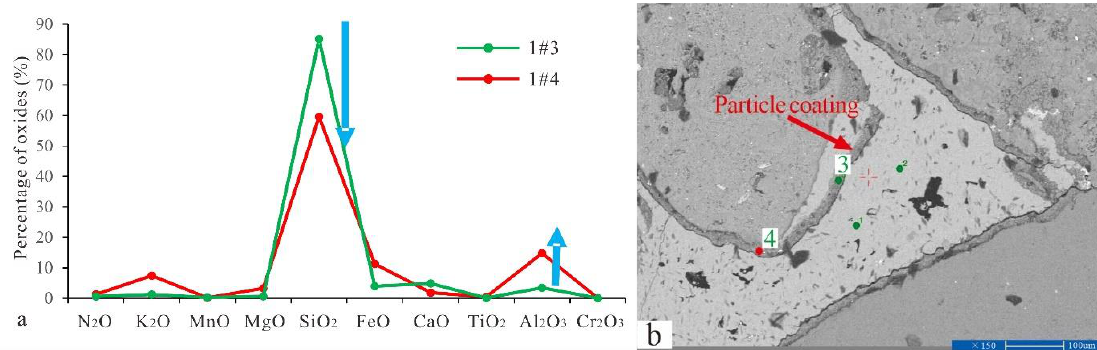
Figure 4. ( a ) The element composition of the coating in the sample of well Q9-3 (number: 1#3 and 1#4; the blue arrow indicates the element that has changed). ( b ) Test positions of 1#3 and 1#4 on the backscatter image.